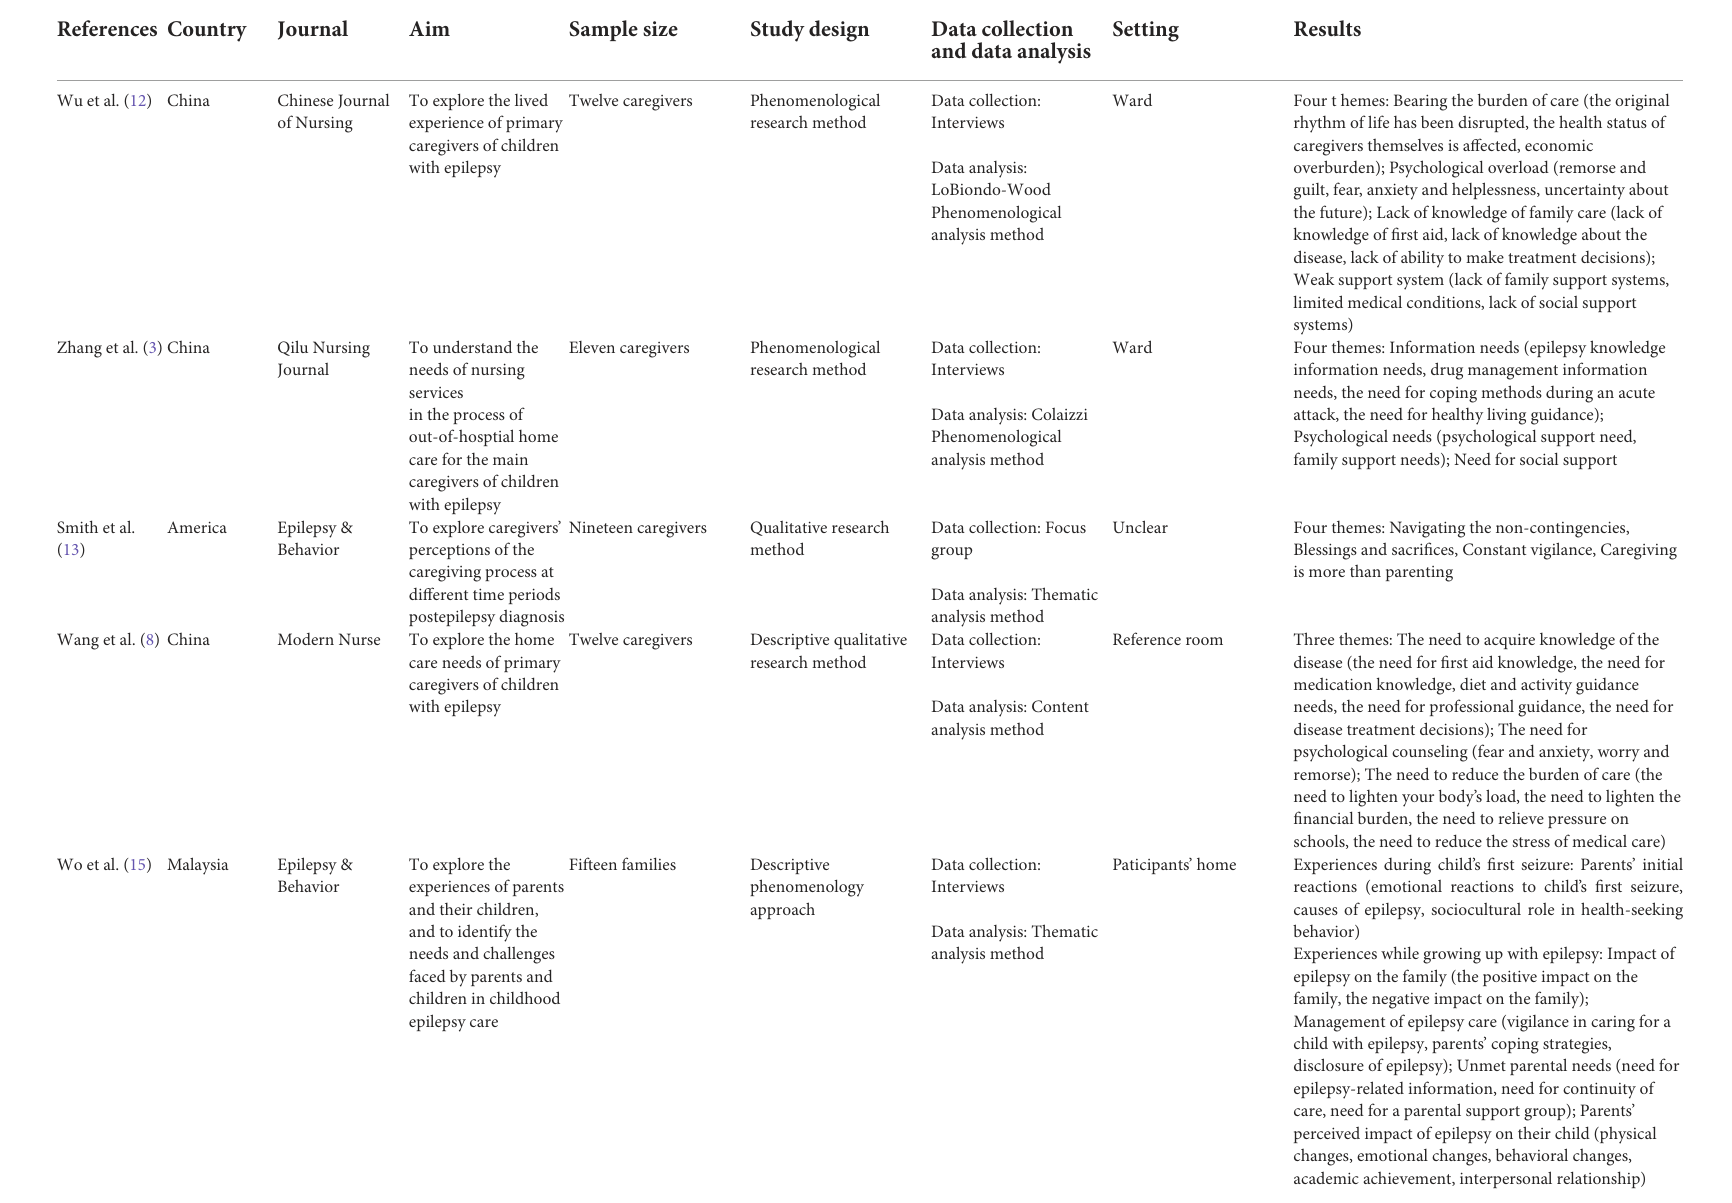
TABLE 3 Description of included